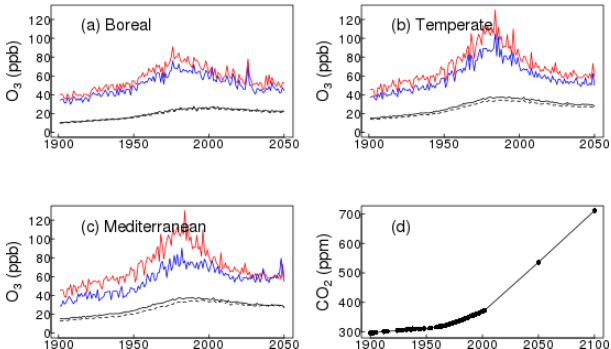
Figure 1. Regional time series of canopy height O 3 (ppb) forcing from EMEP (a–c) and (d) global atmospheric CO 2 (ppm) concen- tration (this does not vary regionally; black dots show data points; the black line shows interpolated points). Each panel for the O 3 forcing shows the regional annual average (woody PFTs, black solid line; herbaceous PFTs, black dashed line) and the annual maximum O 3 concentration above: woody PFTs (red) and herbaceous PFTs